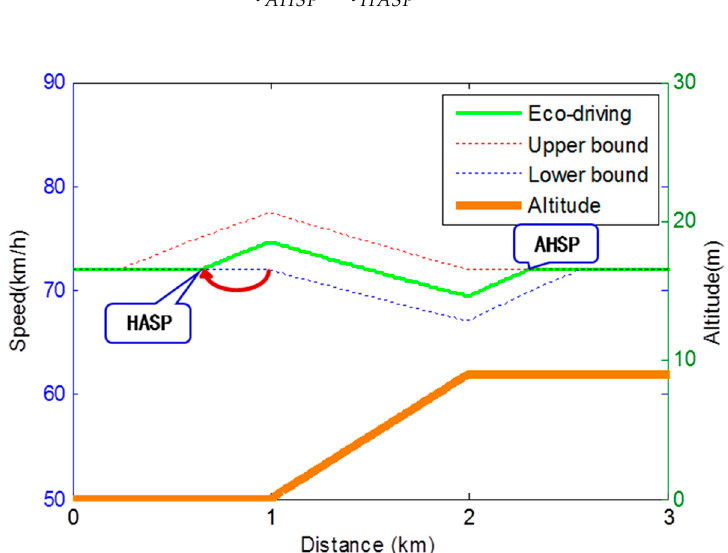
Figure 13. Diagram of the average speed equivalent algorithm for a 1 km steep uphill slope.